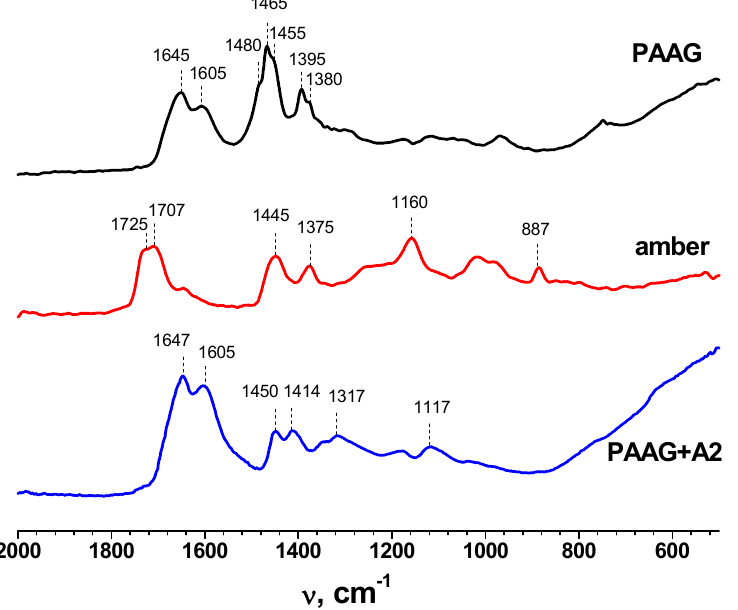
Figure 1. FTIR spectra of amber, polyacrylamide hydrogel (PAAG) and polyacrylamide hydrogel with amber (PAAG−A2).